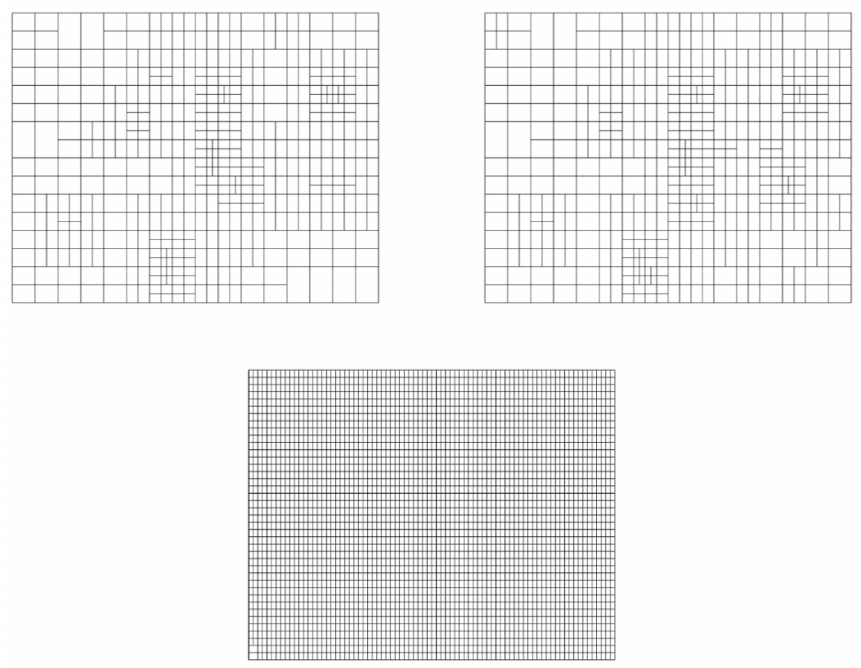
Figure 14. Top: T-mesh corresponding to E00 (link) and E55 (right). Bottom: the NURBS mesh for